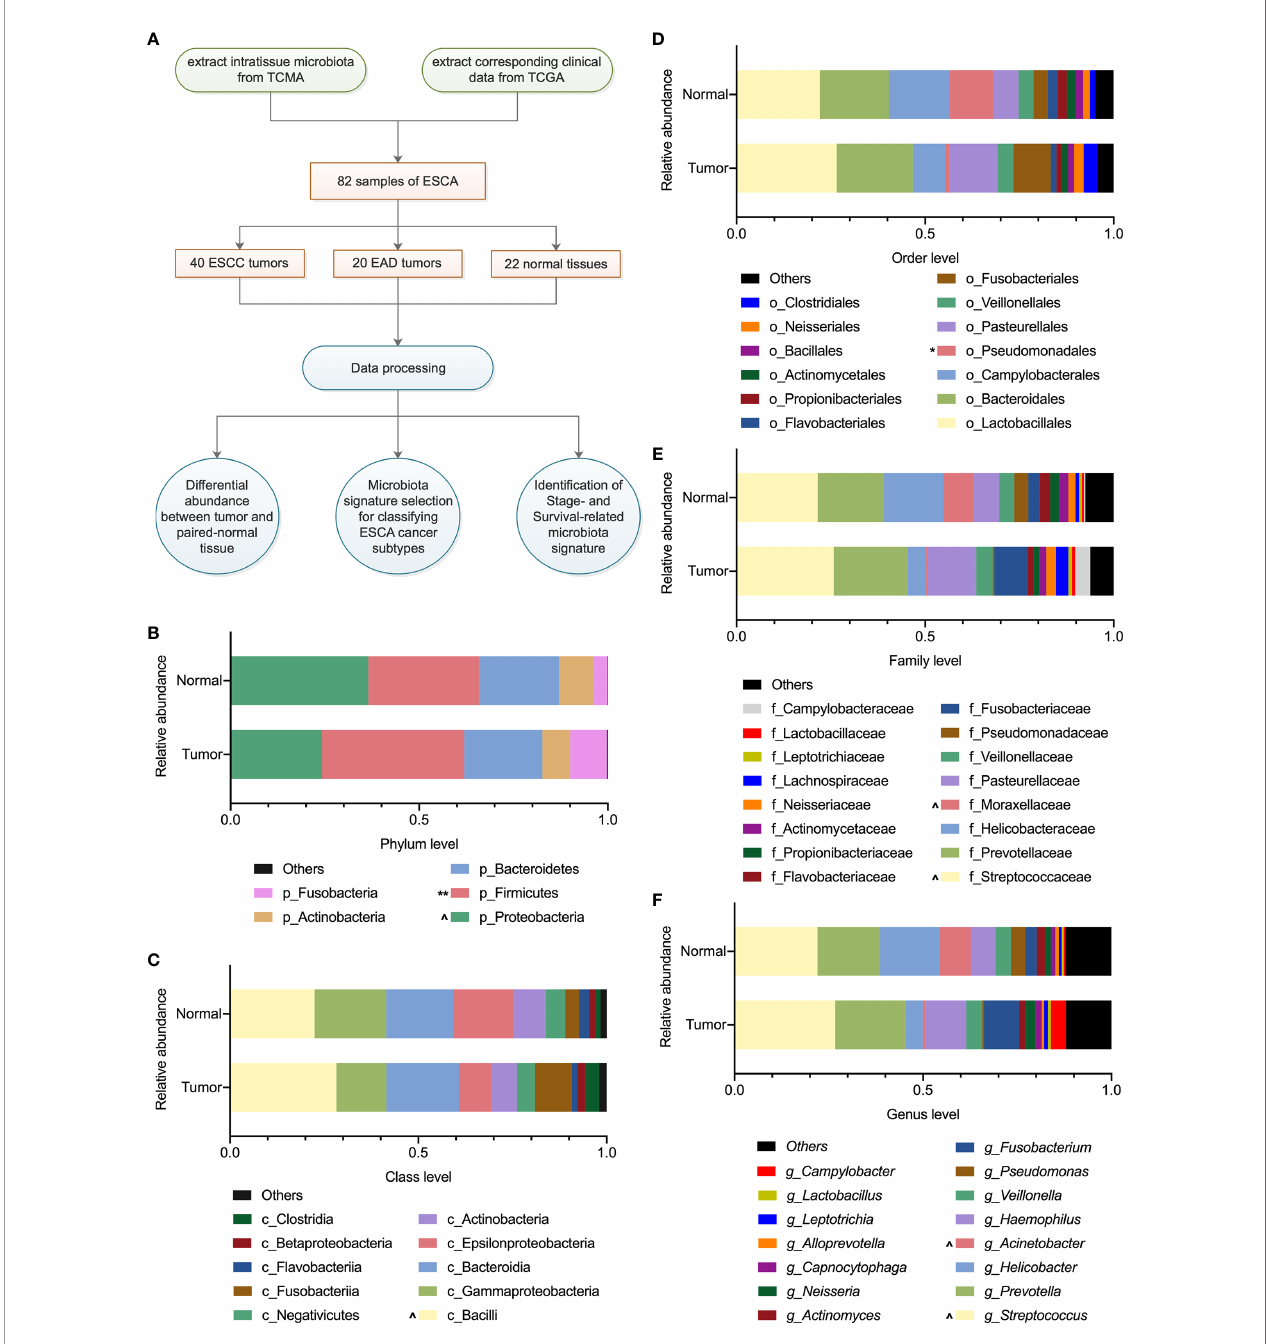
FIGURE 1 | Overview of the study design and microbiota pro fi ling. (A) Schematic overview of the study design. TCMA, the cancer microbiome atlas; TCGA, the cancer genome atlas; ESCA, esophageal carcinoma; ESCC, esophageal squamous cell carcinoma; EAD, esophageal adenocarcinoma. (B – F) The composition of microbiota with an average abundance > 1% in tumor and paired normal tissues at the phylum, class, order, family, and genus levels, respectively. The relative microbial abundance in tumors compared with normal samples, ^0.1 < P < 0.01, * P < 0.05, ** P < 0.01 in paired-samples t